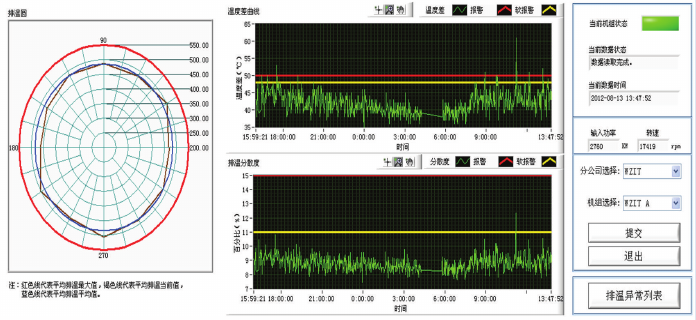
Figure 3: A typical webpage for monitoring of the subsystem.